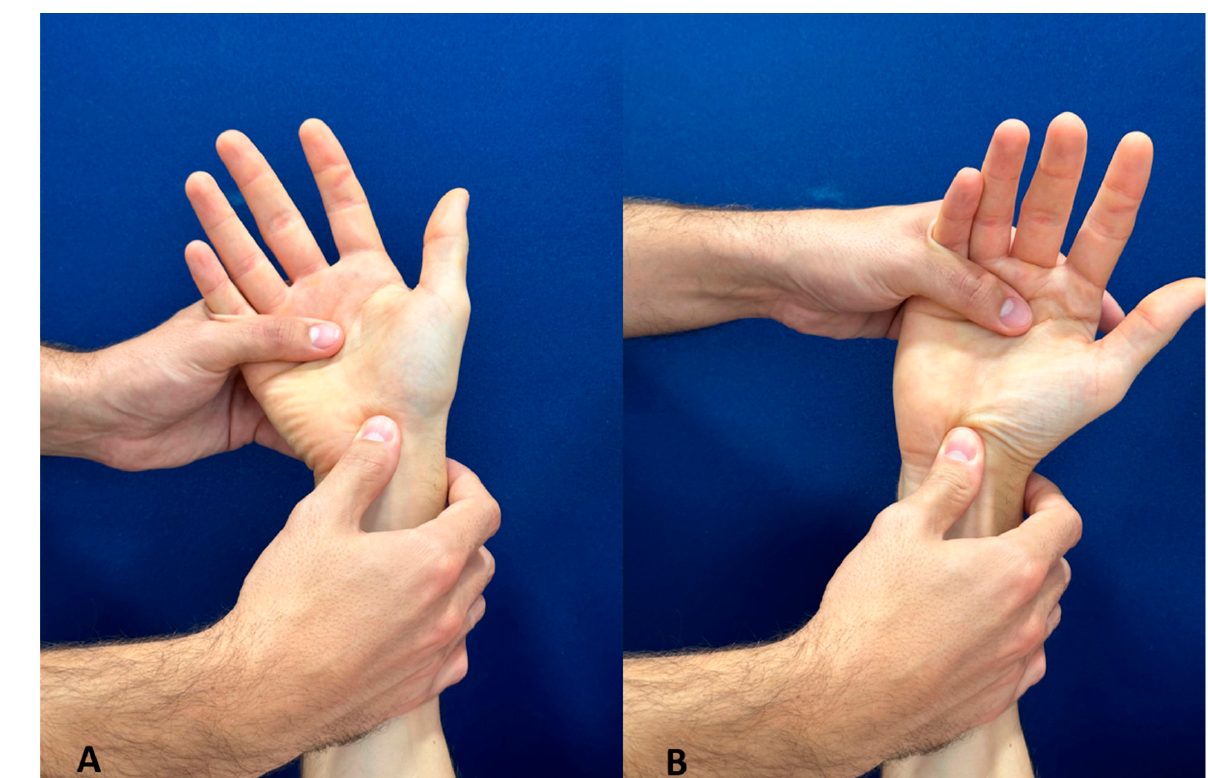
Figure 2. The scaphoid shift test: The examiner places his thumb on the palmar prominence of the scaphoid; the wrist is ulnar-deviated and slightly extended ( A ). The wrist is moved towards the radial side and into slight flexion ( B ).